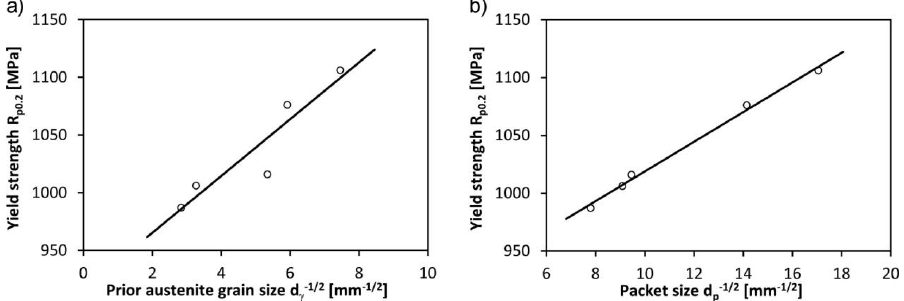
Figure 17. Dependence of the yield strength on the prior austenite grain size ( a ) and the martensite packet size ( b ) for the Hardox 450 steel.